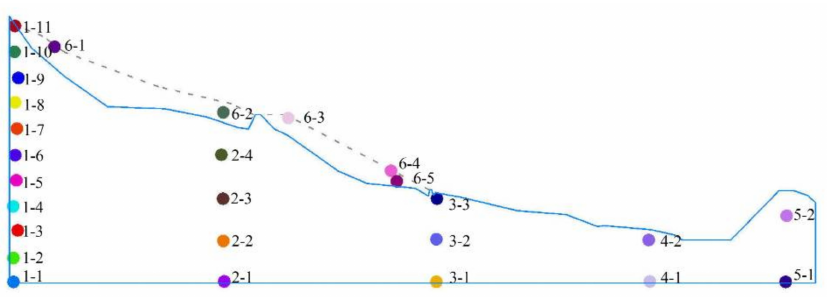
Figure 11. The PDEM model of the rockfill slope.